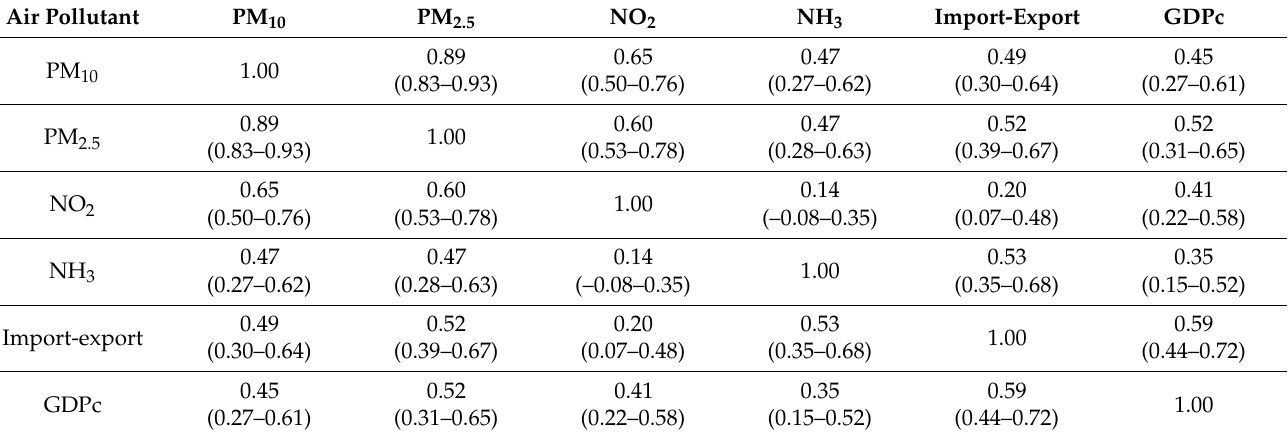
Table 1. Pearson’s correlation coefficients between study variables.